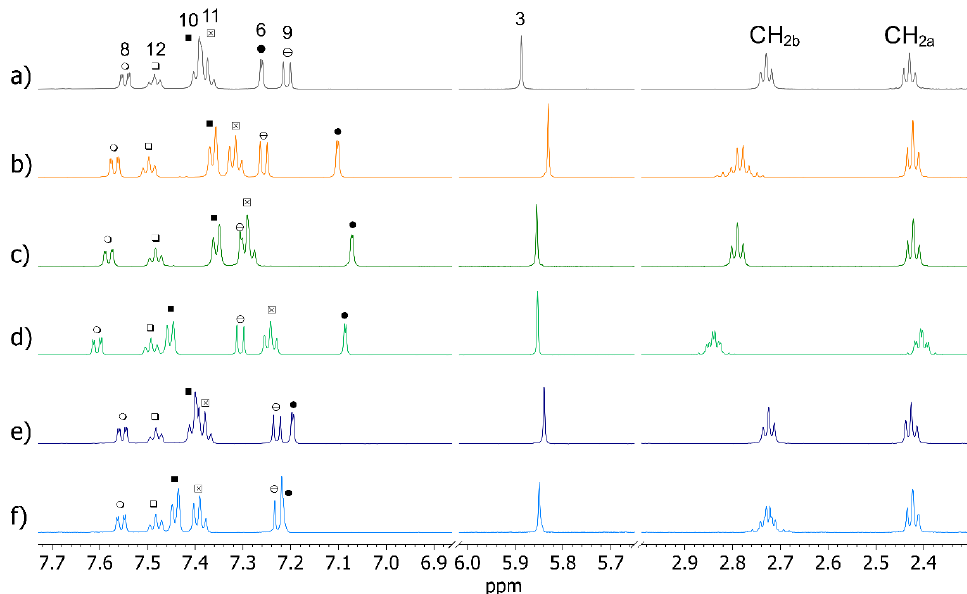
Figure 6. 1 H NMR (600 MHz, K 2 HPO 4 /D 2 O 50 mM, 25 °C) spectra of: ( a ) pure OXEMIS (6 mM), ( b ) OXEMIS/MCD (1:2), ( c ) ( R )-OXEMIS/DIMEB (1:2), ( d ) ( S )-OXEMIS/DIMEB (1:2), ( e ) ( R )- OXEMIS/TRIMEB (1:2), and ( f ) ( S )-OXEMIS/TRIMEB (1:2). Table 2. 1 H NMR (600 MHz, K 2 HPO 4 /D 2 O 50 mM, 25 °C) chemical shifts (ppm) of pure OXEMIS (6 mM) and complexation shifts (Δδ = δ mixture − δ pure , ppm) of OXEMIS in mixture with 2-equivalents of MCD, DIMEB, and TRIMEB.